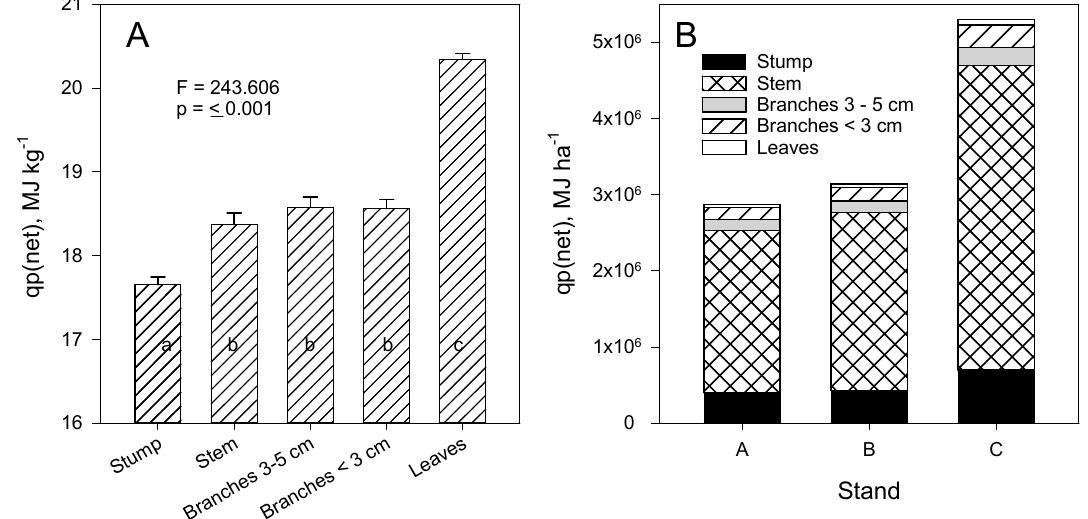
Figure 4. The effective heating value of the oven dry biomass ( qp(net) ) of rubber wood compartments ( A ) and the energy content of rubber tree plantations that were 20 years Stand A), 25 years (Stand B), and 30 years (Stand C) of age ( B ). Means marked with the same character do not differ from each other according to Tukey’s test at significance level of p < 0.05.